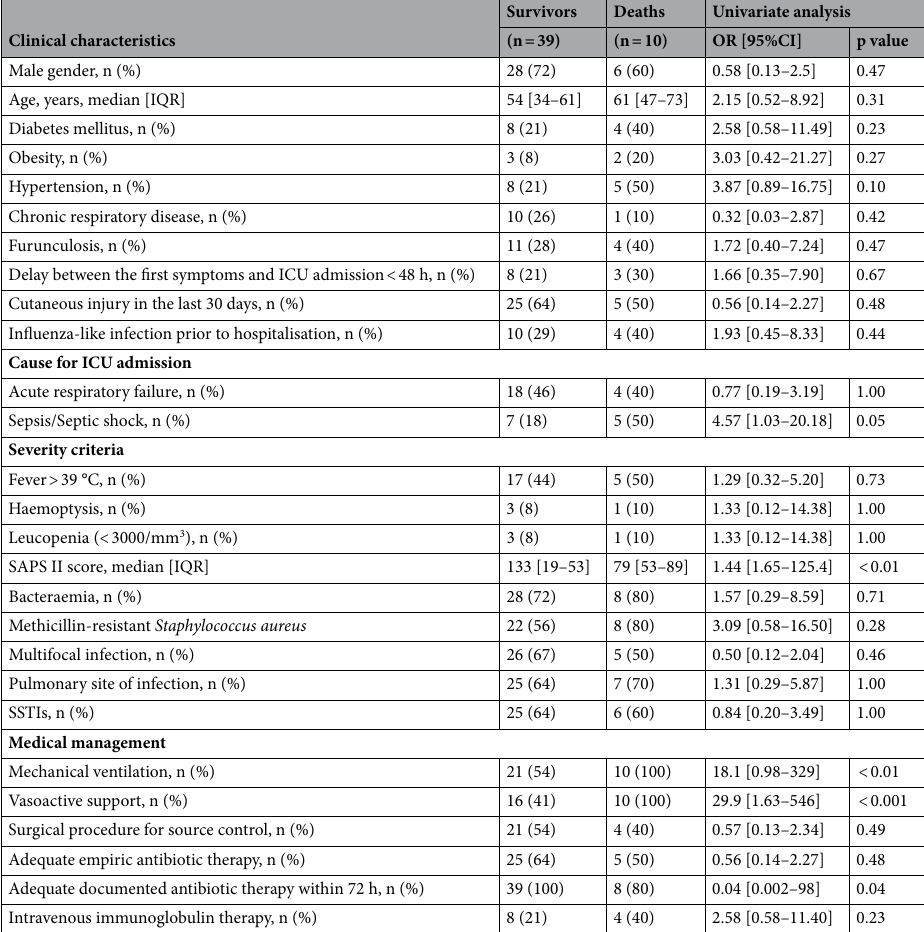
Table 3. Comparison of clinical characteristics and management of survivors and deaths in adult patients in univariate